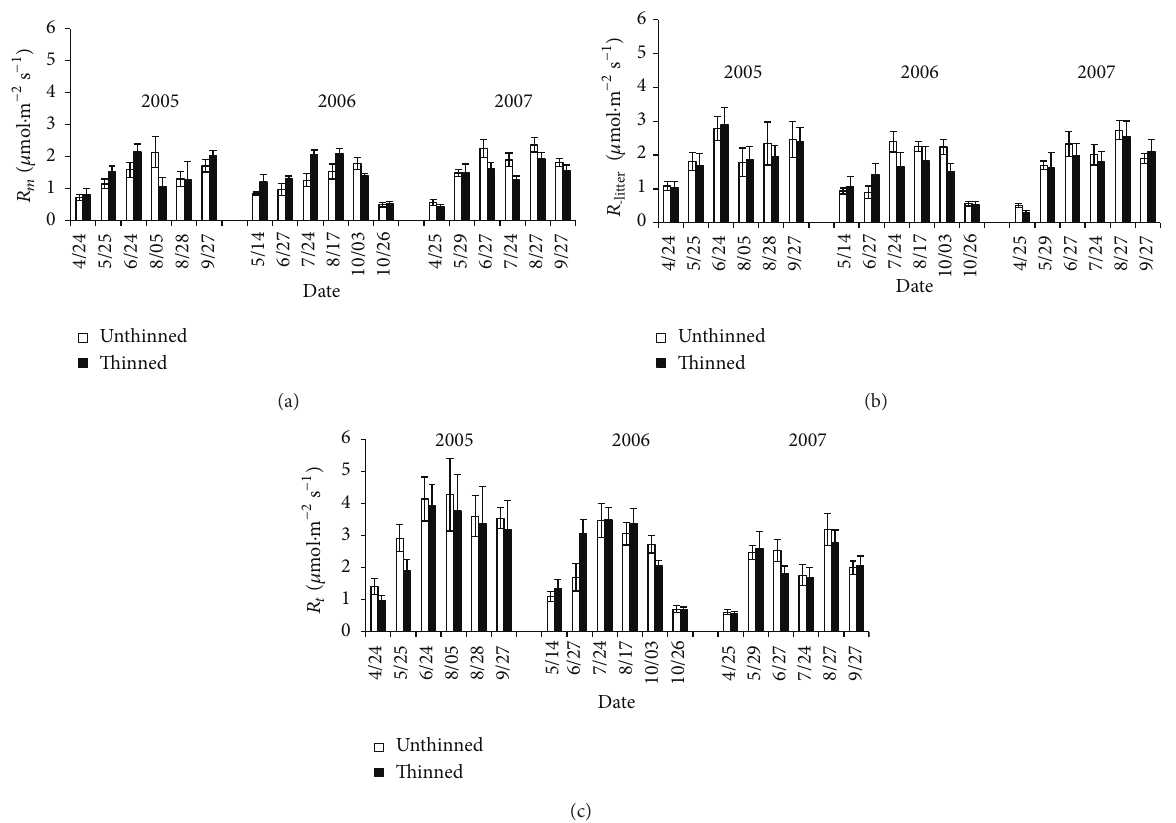
Figure 3: Comparison of 𝑅 𝑚 , 𝑅 −